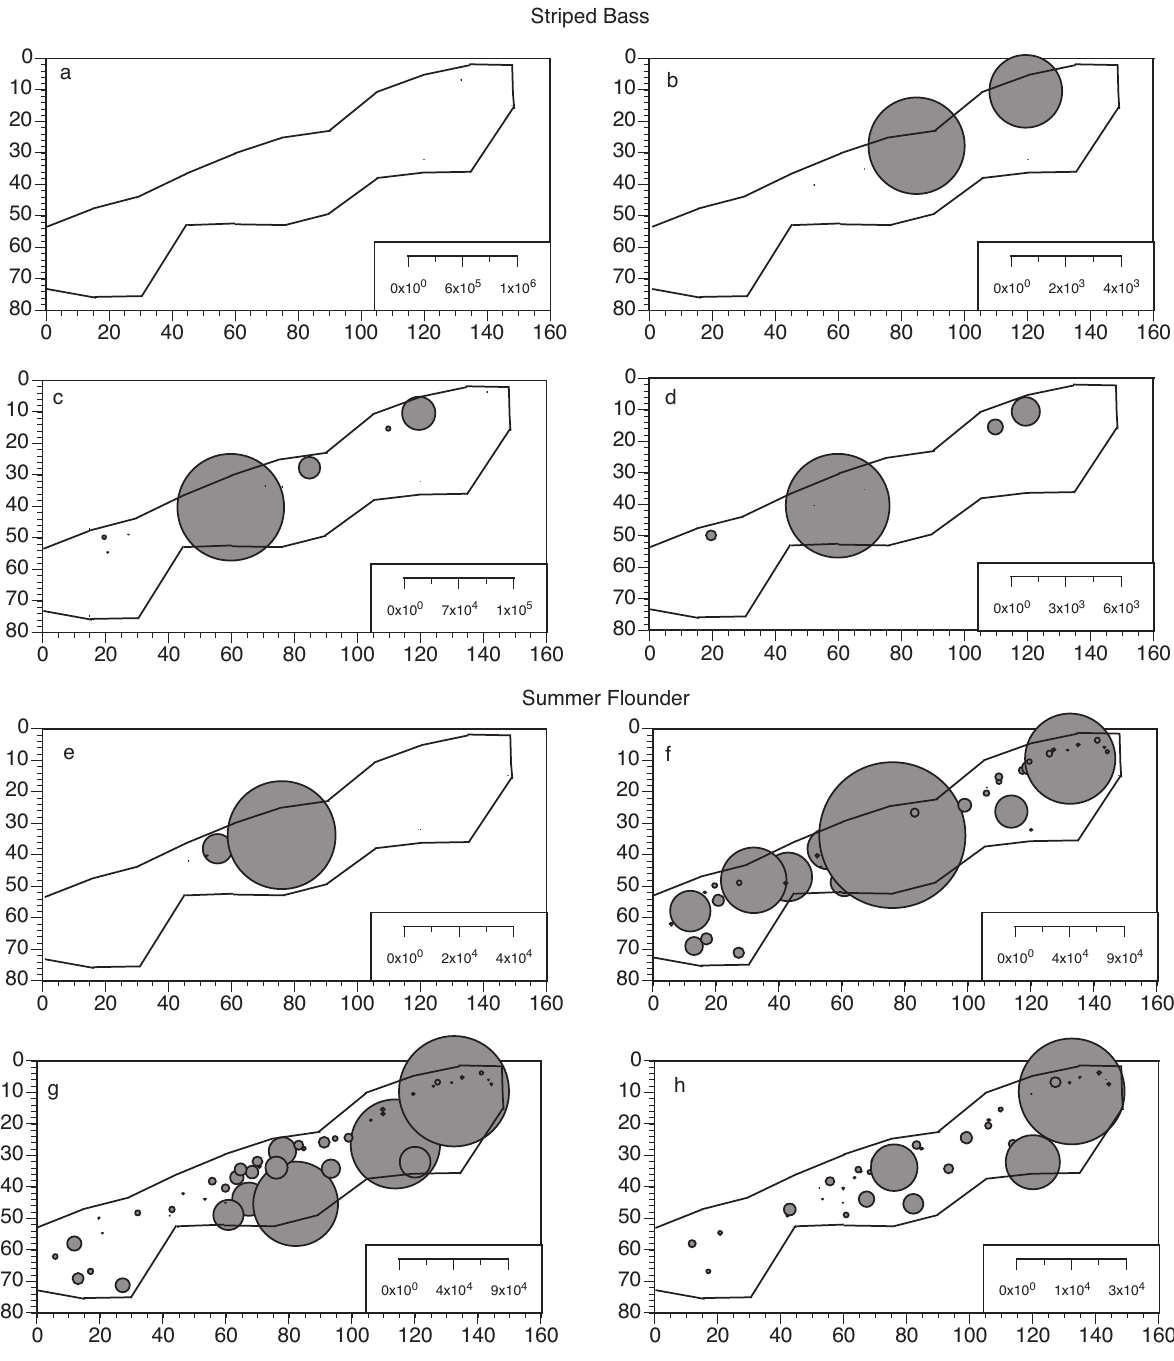
Figure 5 for further